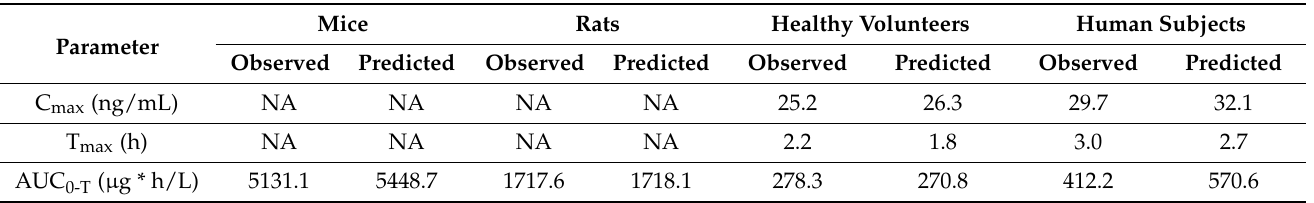
Table 7. Simulated and observed pharmacokinetic parameters for matrine in mice, rats, healthy volunteers and human subjects in the PBPK model.